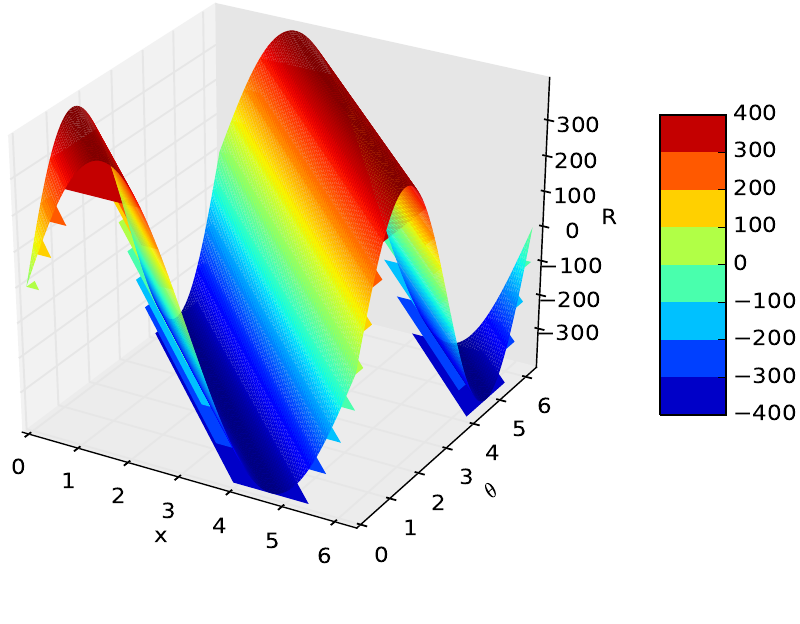
Figure 17. 3D surface folded under rolling contact due to compressive and tension loads in MPa.